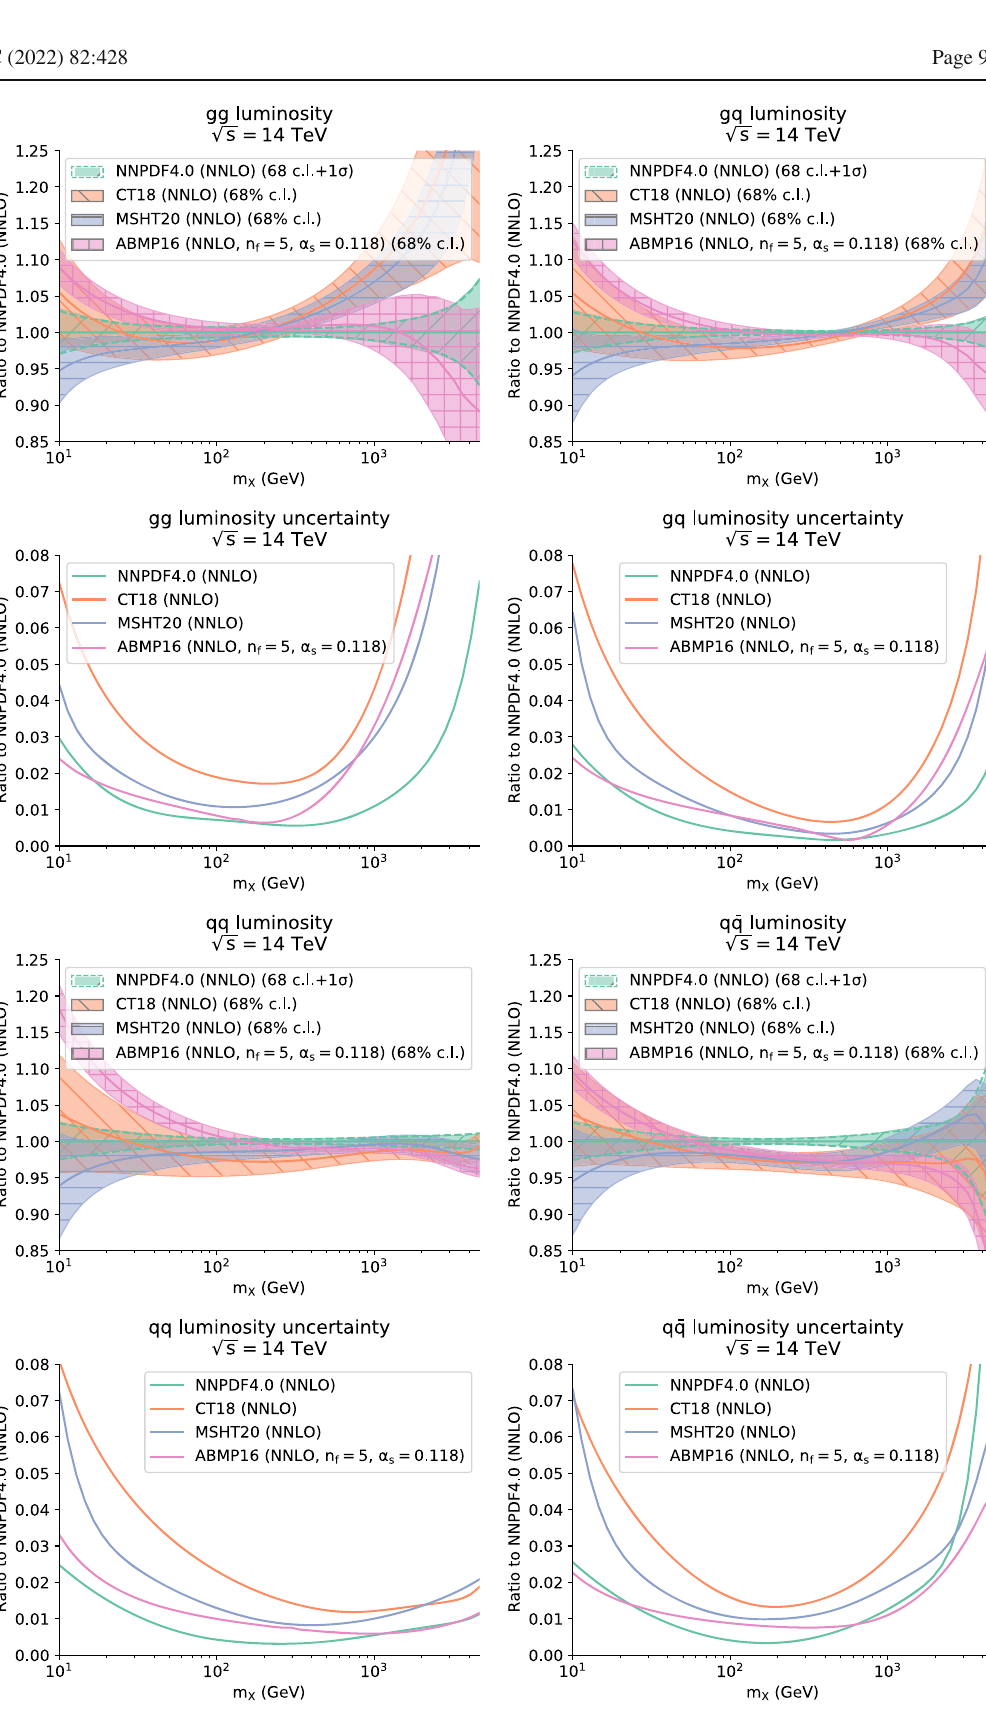
Fig. 60 Same as Fig. 58 but now comparing NNPDF40, ABMP16, CT18, and MSHT20